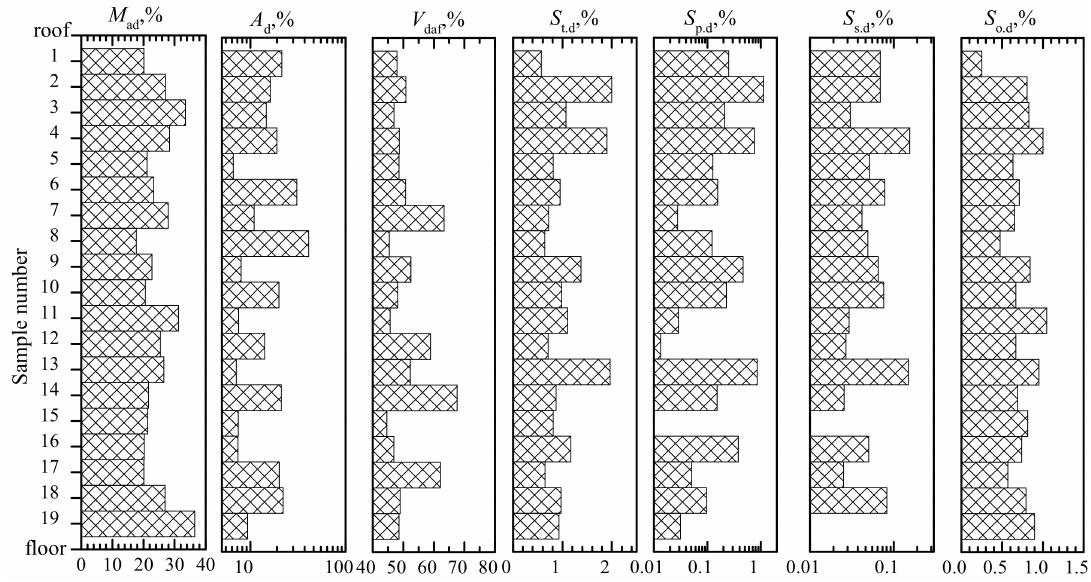
Figure 2. Proximate and sulfur